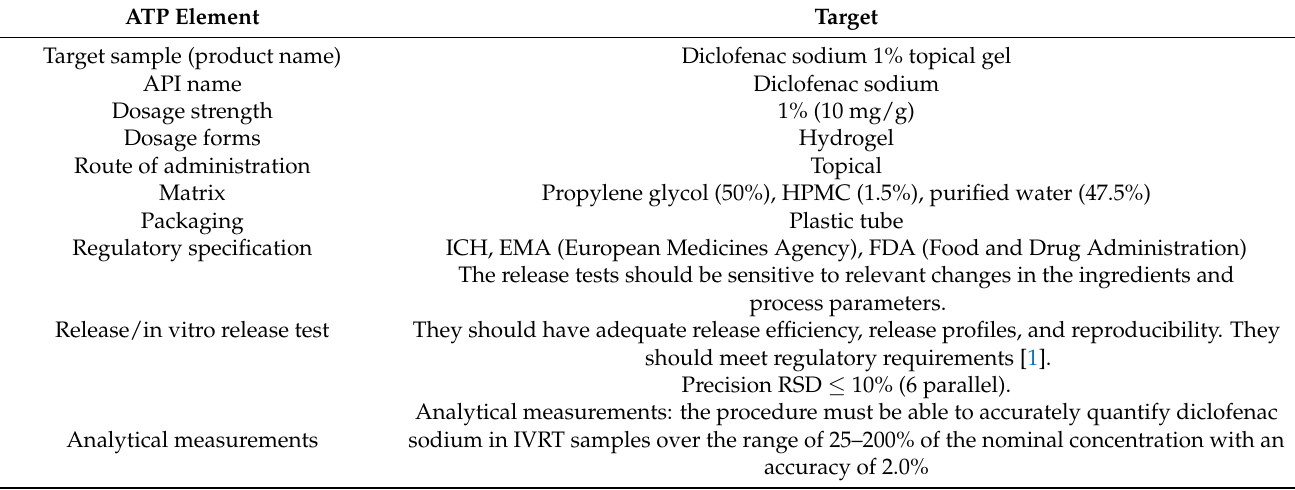
Table 2. Analytical target profile of diclofenac sodium topical